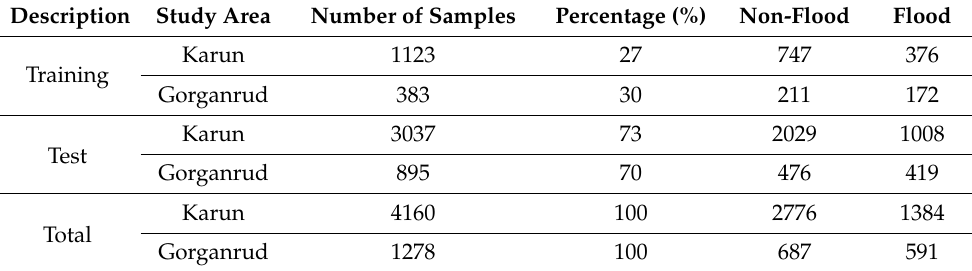
Table 1. The training and test samples of flooded and non-flooded areas.